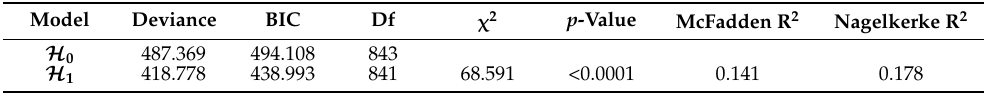
Table 13. Summary of the logistic model characterizing the relationship between the variable Y 3 “Have you been hospitalized?” and the variables X 1 and Z 1 (Model